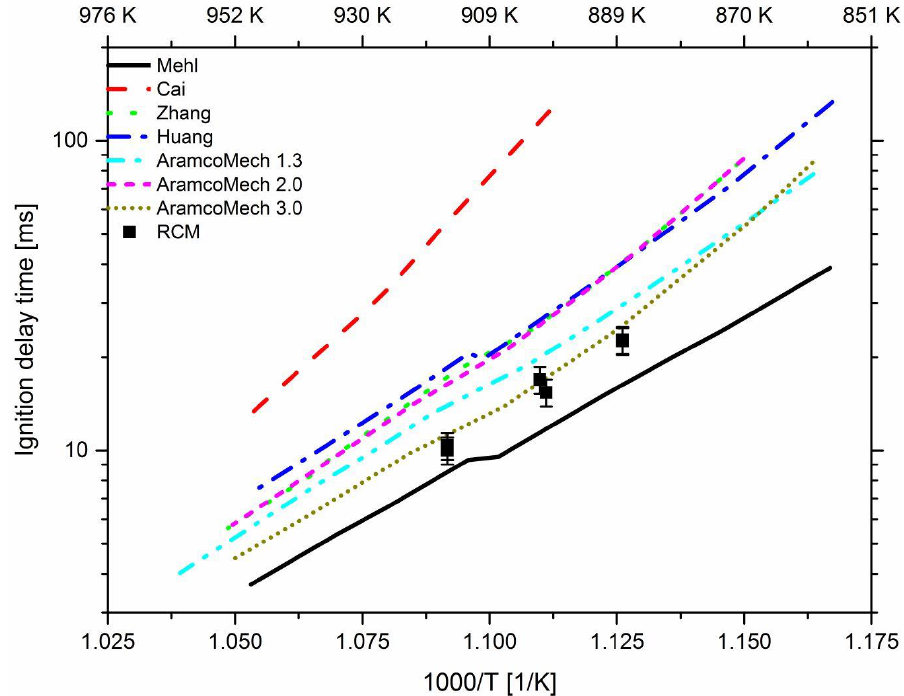
Figure 5. Experimental RCM data (symbols) [37] versus model prediction at P c = 100 bar using 95 mol % CH 4 and 5 mol % C 3 H 8 at λ = 1.9.